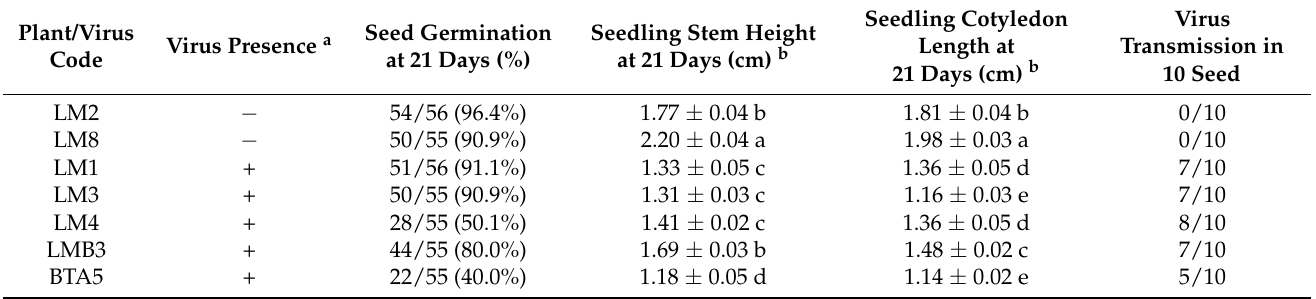
Table 2. Seed (vertical) transmission of YTMMV and germination and growth characteristics of Solanum nigrum